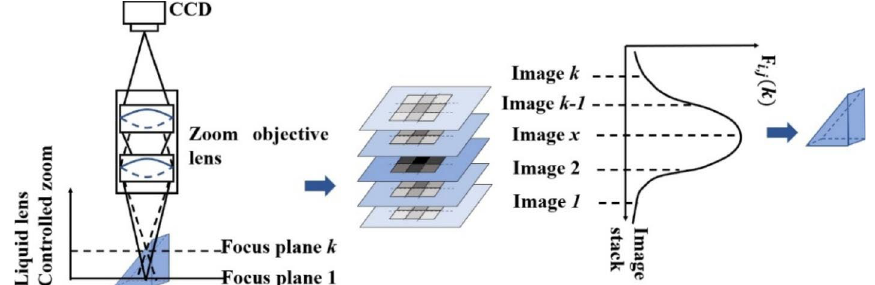
Fig. 2 Schematic of the 3D reconstruction